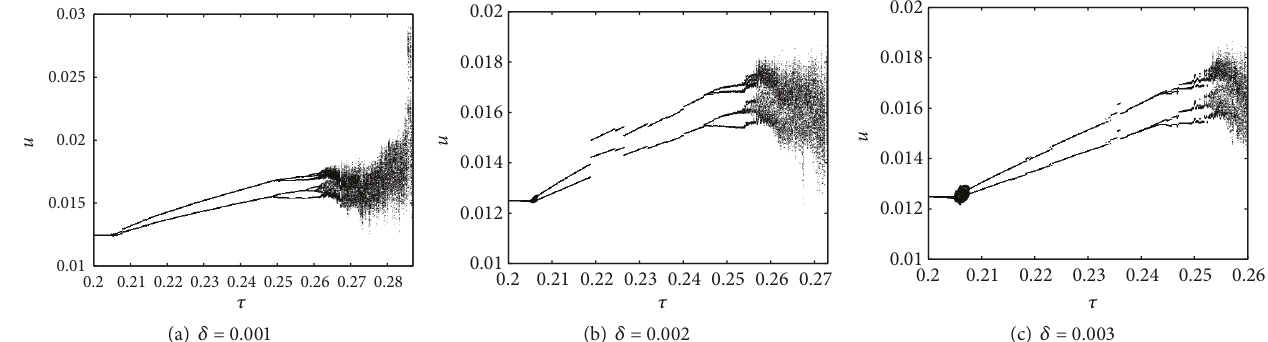
Figure 9: Flip bifurcation diagram of the coupled dynamical network with different coupling strengths. Globally coupled network is applied, 𝑁 = 20 . Other parametric conditions are the same with Figure 1.